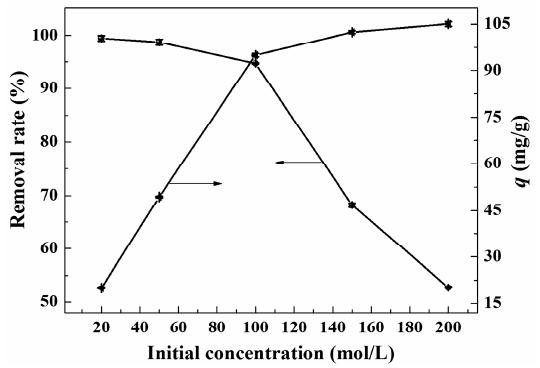
Figure 11. Effect of initial concentration on the MB adsorption (dosage of the adsorbents: 1.0 g/L).